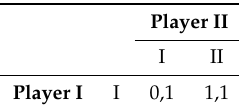
(cid:104) σ , II (cid:105) is loss